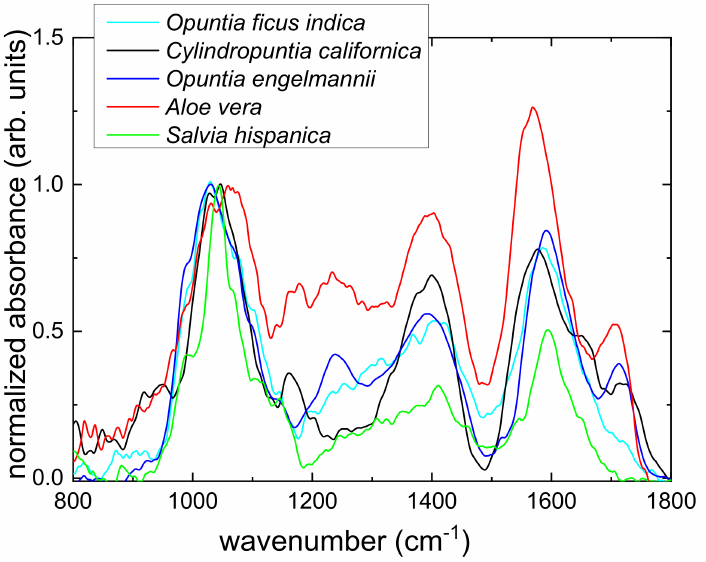
Figure 1. Normalized infrared absorption spectra of mucilages extracted from the different species reported in the